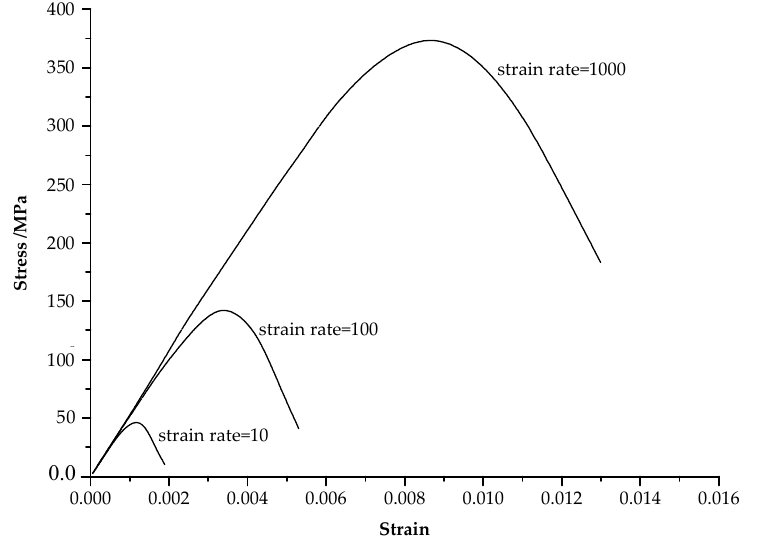
Figure 3. Stress ‐ strain curves under different strain rates simulated using the proposed model.